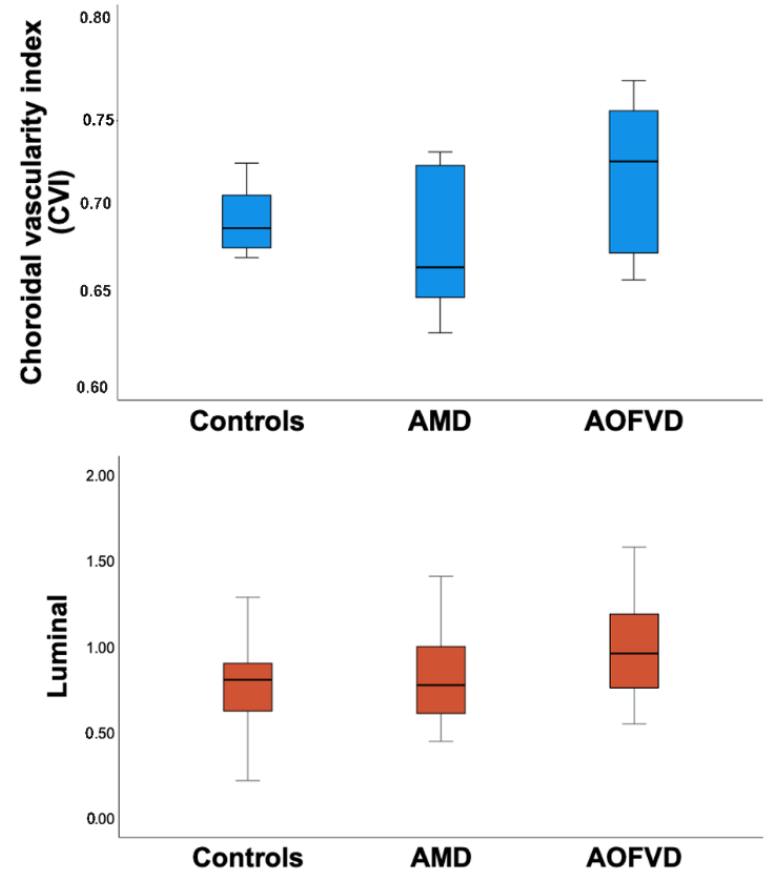
nent (bottom, orange) into the three different subgroups, including controls, age-related macular degeneration (AMD), and adult-onset foveomacular vitelliform dystrophy